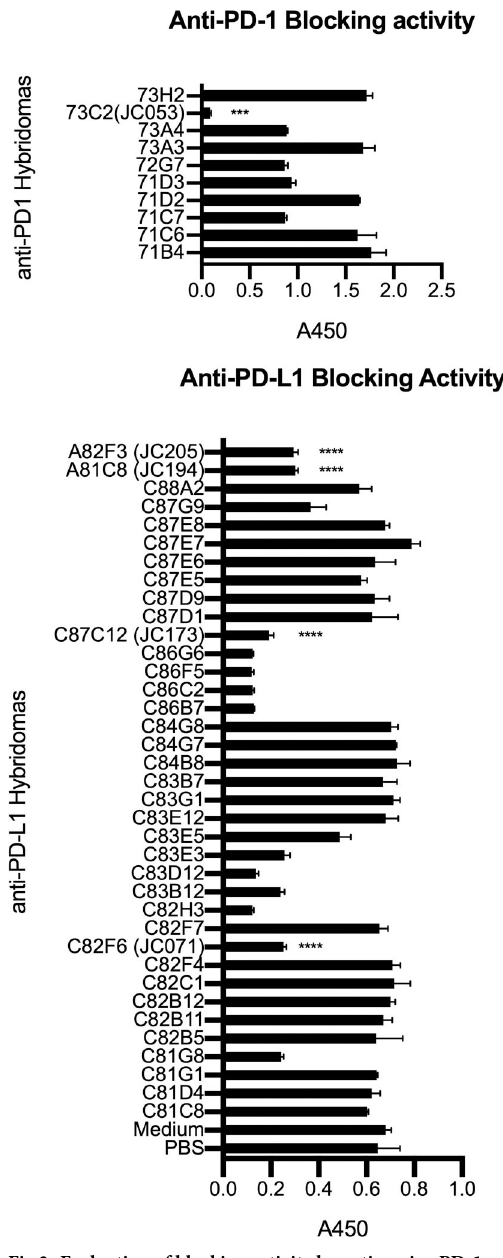
Fig 2. Evaluation of blocking activity by anti-canine PD-1 and PD-L1 antibodies. Antibodies were screened for their opposite ligand blocking capability. Hybridoma supernatants were added to ELISA plates coated with unbiotinylated PD-1Ig (A) or PD-L1Ig (B). After washing, biotinylated PD-L1Ig (A) or PD-1Ig (B) was used to detect blocking capacity of anti-PD-1 (A) and anti-PD-L1 (B) using HRP conjugated streptavidin to detect unblocked protein. All samples were assayed in duplicates. Each value is presented as mean ± standard deviation. In (A), JC053 value was significantly different from the rest of anti-PD-1 hybridomas with P value of 0.0002. In (B), JC071, JC173, JC194, and JC205 values were significantly different from PBS and medium values with P values less than 0.0001. subsets in the absence of stimulation with a positive frequency range of 6 to 23% (Fig 5). As expected, stimulation with ConA generated increased frequencies of PD-1 + CD4 + and CD8 + T cells (78–94%) (Fig 5).